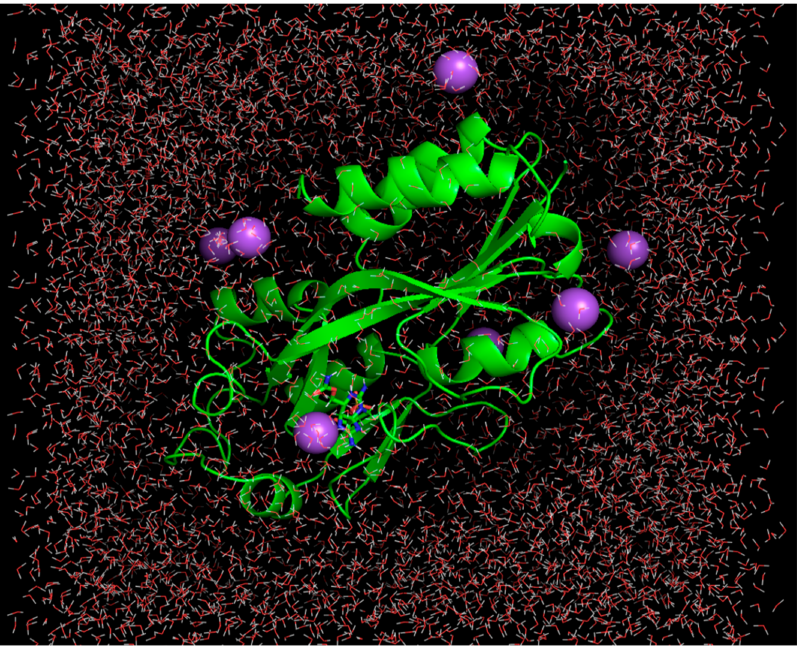
Figure 1. Waterbox containing MvfR-Top-1 lead complex. The MvfR structure is shown via the green cartoon, while Top-1 lead is represented by the green stick. The purple balls are Na + ions while the small red-white sticks are water